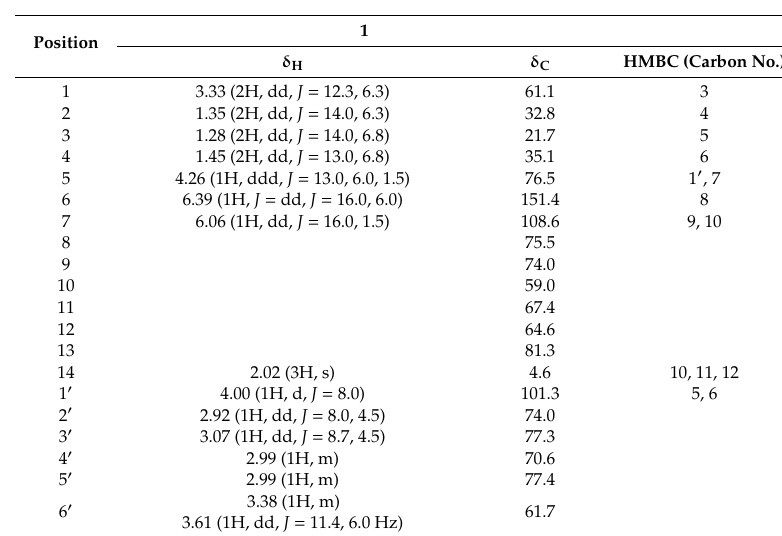
Table 1. 1 H-NMR (500 MHz) and 13 C-NMR (125 MHz) spectral data (DMSO- d 6 , δ in ppm) of 1 isolated from Coreopsis lanceolata